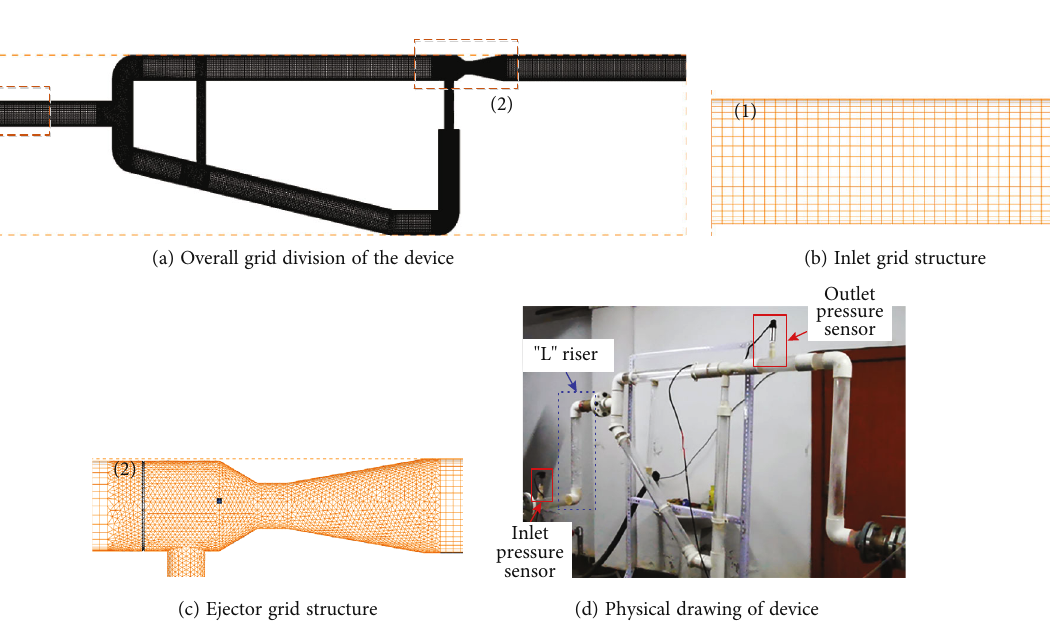
Figure 3: Experimental fl ow chart.